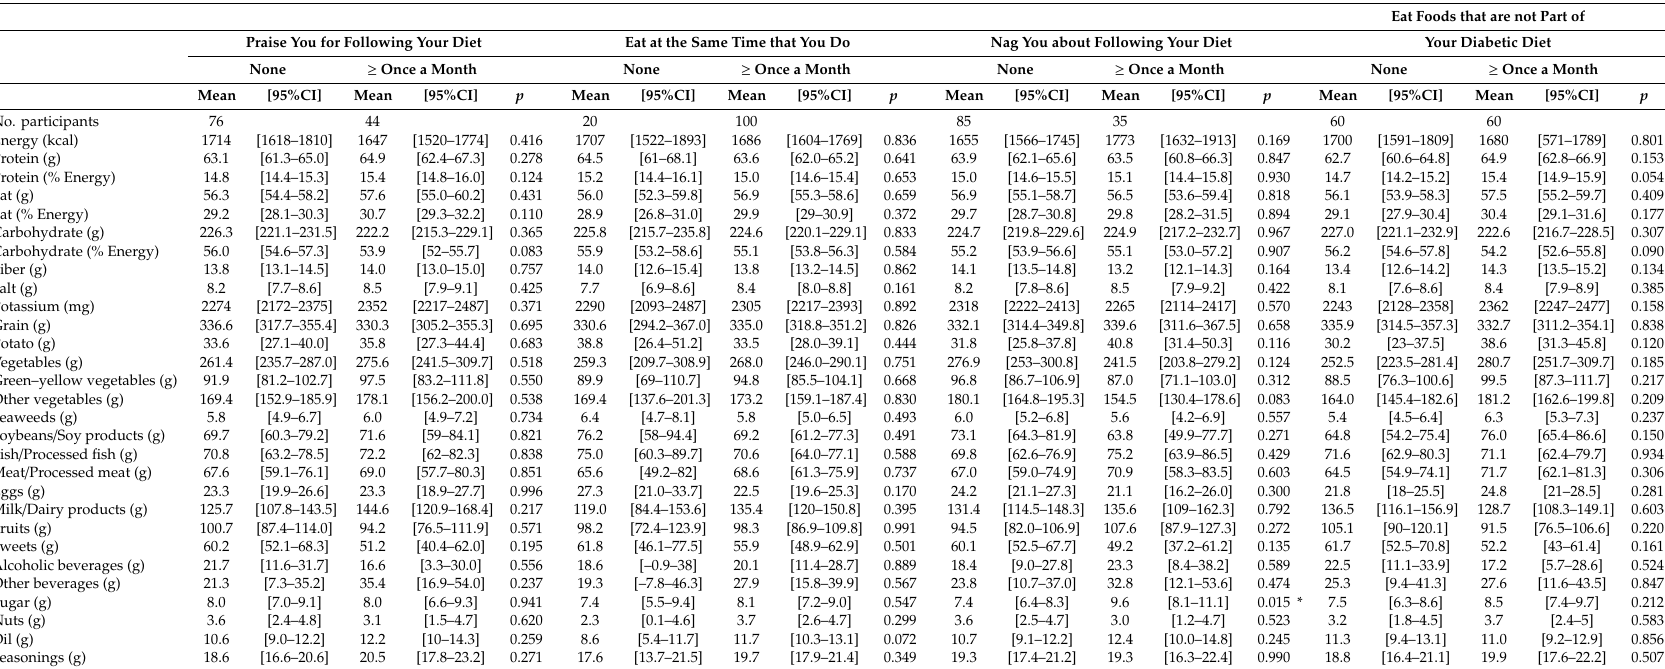
Table 4. Dietary intake and response to the Diabetes Family Behavior Checklist scale for medical nutritional therapy in women with type 2 diabetes ( N =